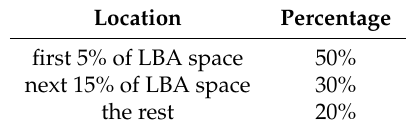
Table 3. Distribution of writes in terms of location. LBA, Logical Block Address.